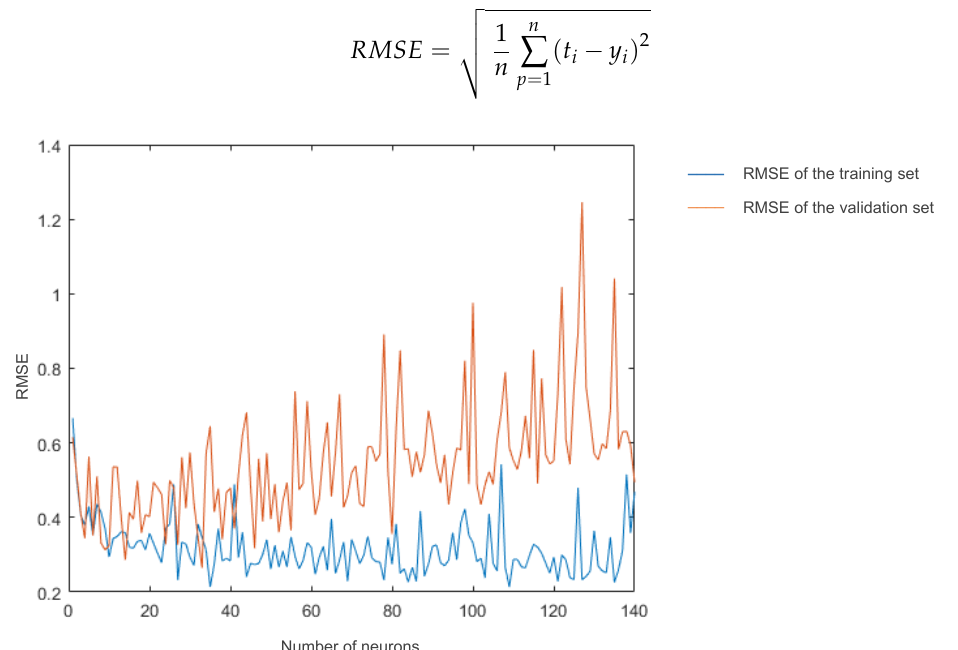
Figure 8. Trend of the RMSE of the training (blue) and validation (orange) datasets within Database